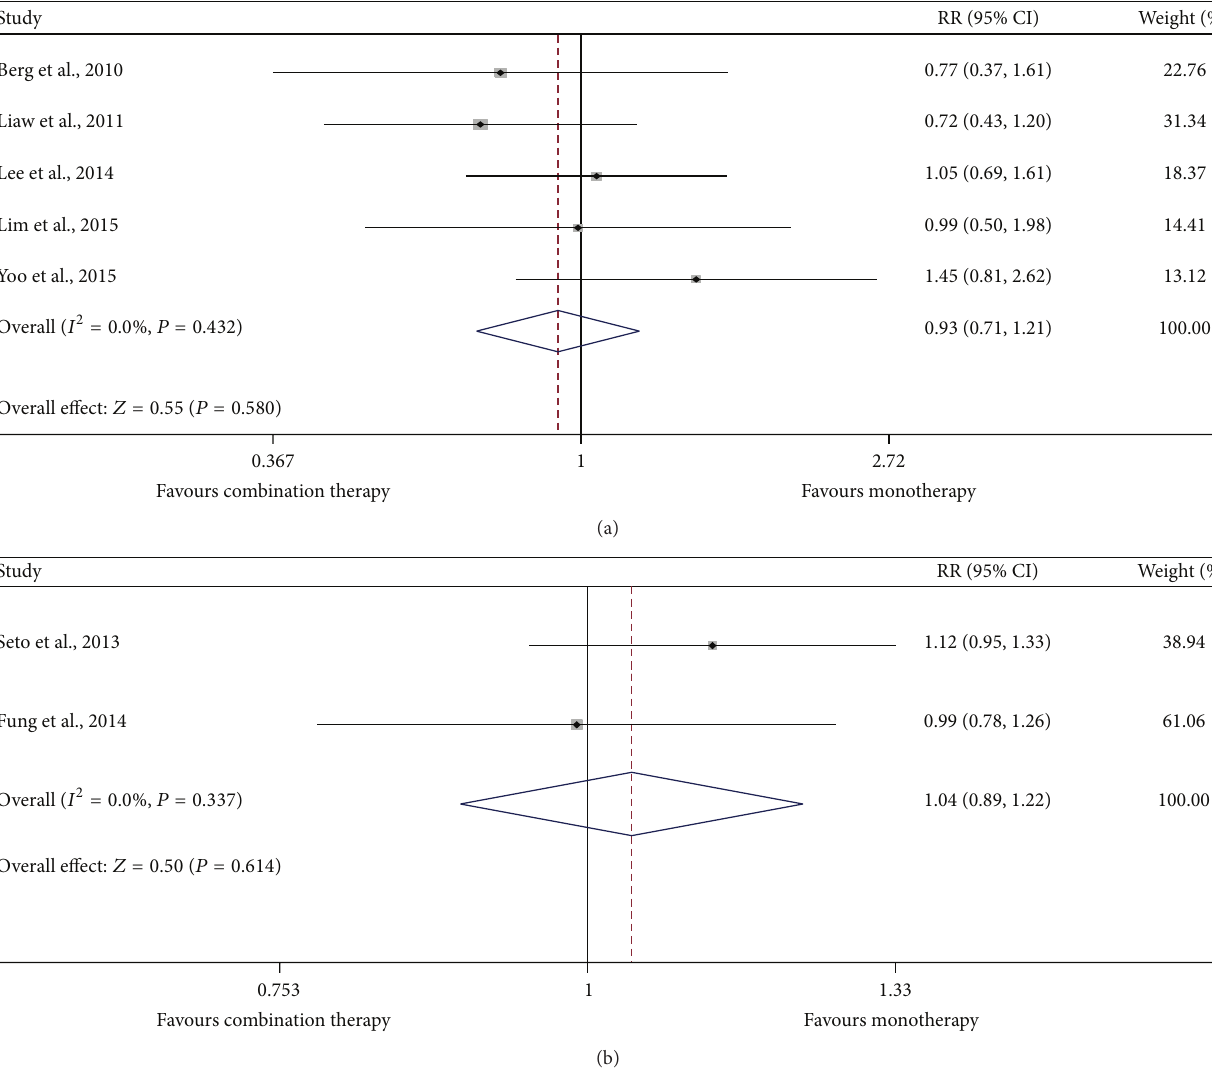
Figure 4: Forest map of summary estimates for comparison of ALT normalization between TDF-based combination therapy and monotherapy groups. (a) 48-week ALT normalization; (b) 96-week ALT